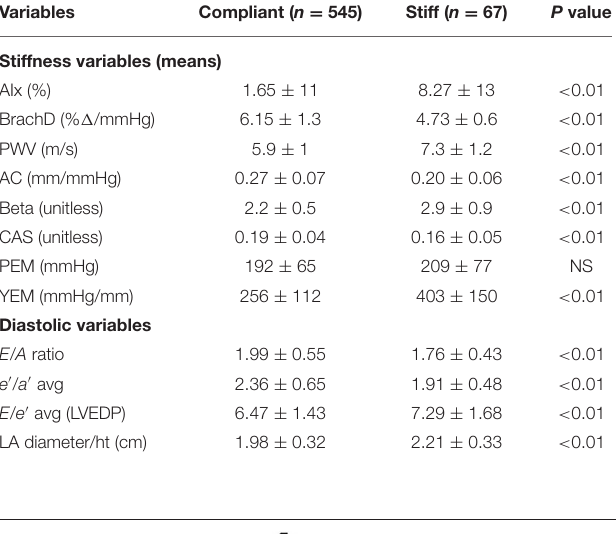
TABLE 2 | Cardiovascular parameters stratified by arterial stiffness category (mean ± SD).